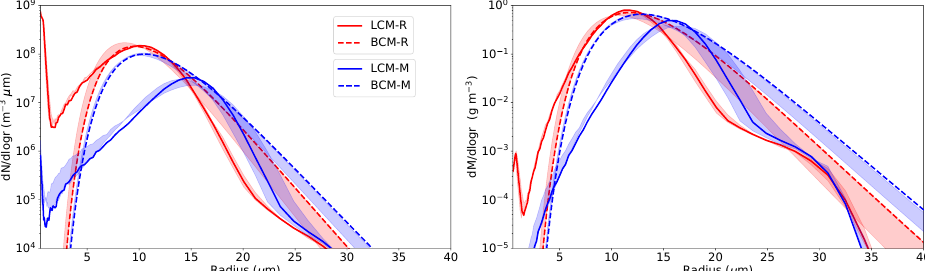
Figure 5. Instantaneous drop size distributions at 0600UTC at 2m height of the simulations listed in Table 2. The shaded area indicates the shift of the spectrum in an interval of 1 h around the discrete